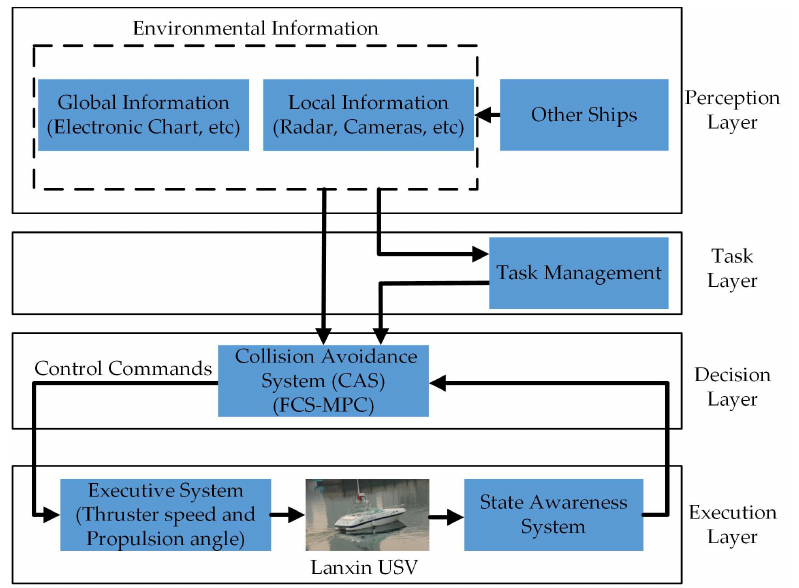
Figure 2. The hierarchical structure of the Lanxin USV system. FCS, finite control